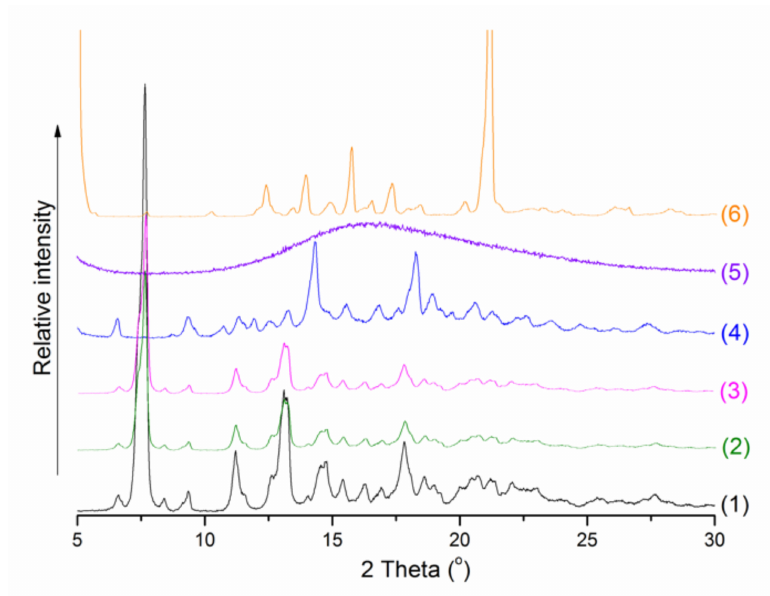
Figure 11. PXRD patterns of compounds ( 1 – 6 ). (compounds numbering corresponds to Figures 2 and